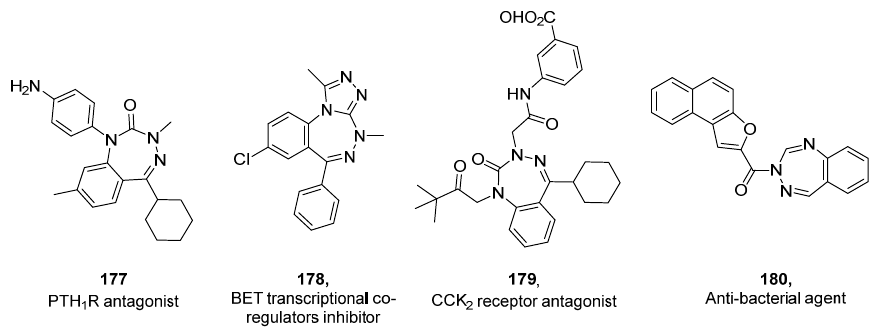
Figure 11. Representative examples of bioactive benzotriazepines.